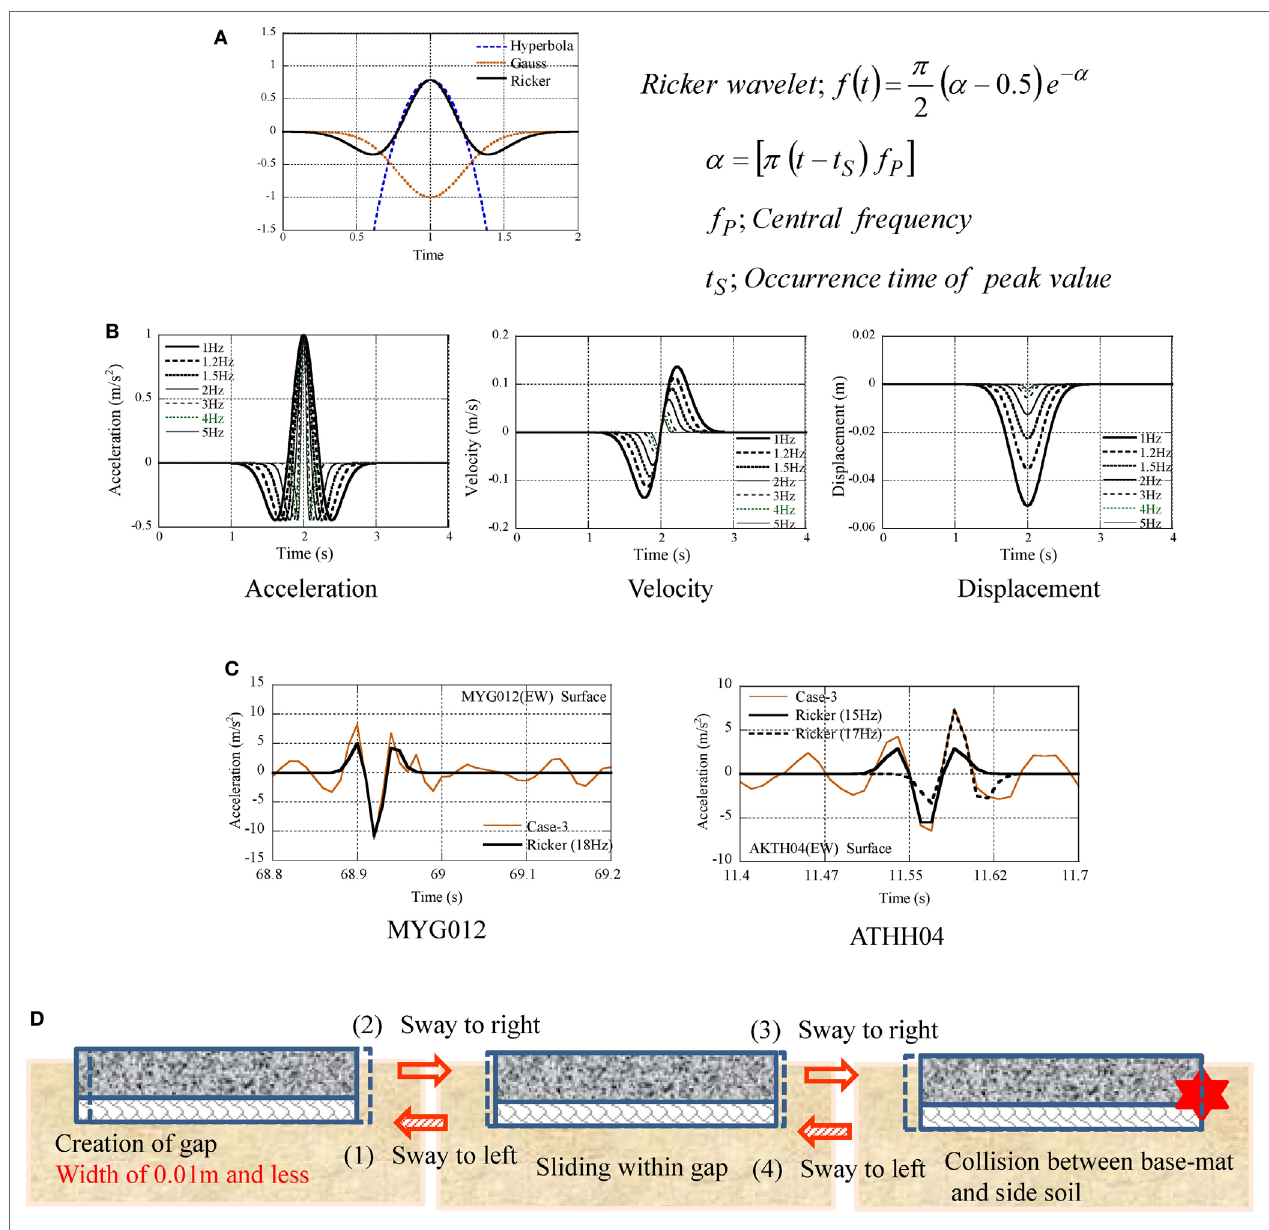
FigUre 11 | Identification of pulse wave by Ricker wavelet, (a) components of Ricker wavelet, (b) wave shape of Ricker wavelet, (c) identification of pulse wave by Ricker wavelet, (D) pulse wave by collision between the observation-house and the side